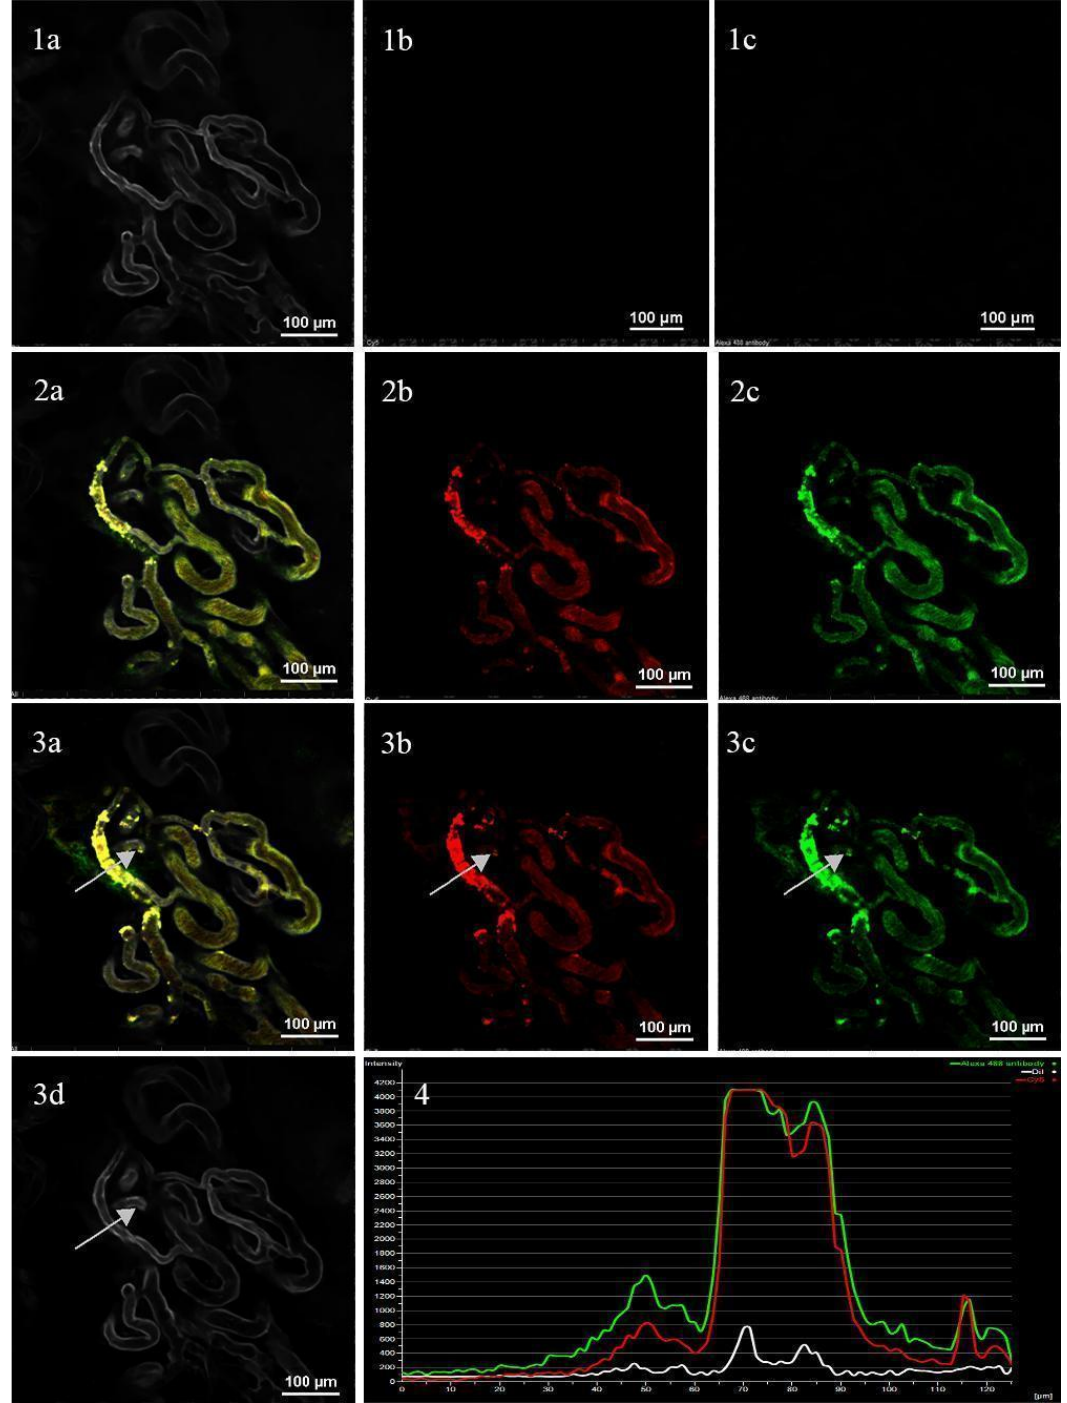
Figure 8. IVM study of hMNP-FITC and PLGA-Cy5 NP distribution in tumor vasculature and peritumoral area in 4T1 tumor—bearing mice upon simultaneous administration (0–45 min after NP injection). The white arrow points to the extravascularly located NP (microleakage). Line 1 ( 1a – 1c )—1 min of PLGA-Cy5 NP exposition; line 2 ( 2a – 2c )—15 min; line 3 ( 3a – 3d )—30 min. ( 1a – 3a ) Merged image (hMNP-FITC and PLGA-Cy5 + CD31-PE); ( 1b – 3b ) PLGA-Cy5 NP (red channel); ( 1c – 3c ) hMNP-FITC (green channel); ( 3d ) CD31-PE; 4 —fluorescence intensity profile along the vector (white arrows in images 3a–d). X-axis— µ m; Y-axis—fluorescence intensity (standard units); the colors correspond to the channels. Scale bar—20 µ